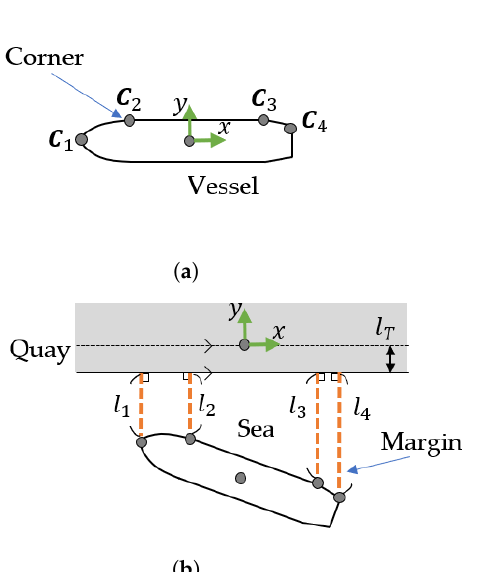
Figure 4. Margin between a vessel and its quay: ( a ) vessel-based coordinate system; ( b ) quay-based coordinate system.